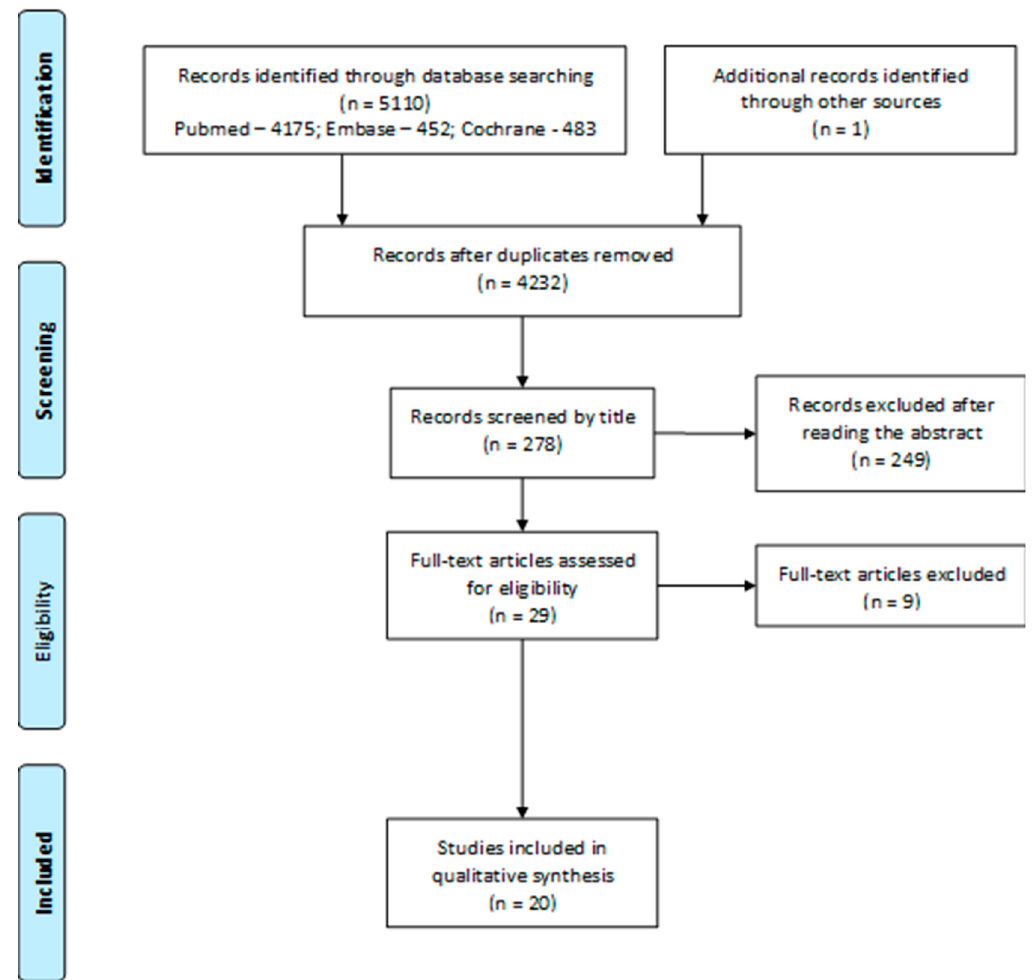
Figure 1. Flow diagram of the study selection.